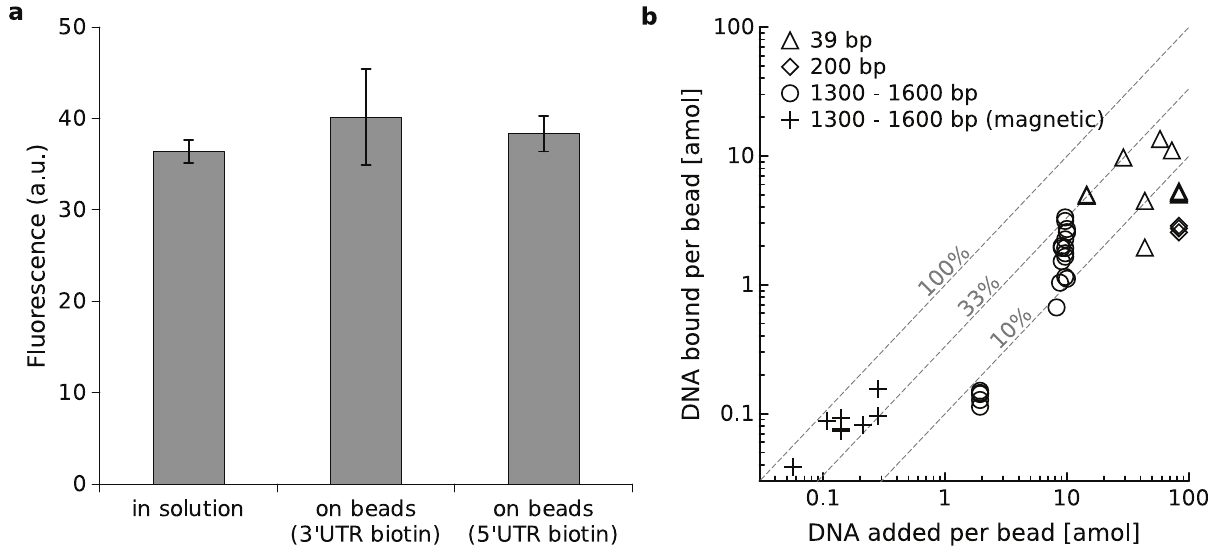
Fig 1. DNA immobilization on beads and expression in ¼ l-scale reactions. (a) Comparison of fluorescent protein expressed in 25 μ l reactions from DNA in solution or equivalent amounts of DNA directly immobilized on beads. Error bars show standard deviation calculated from three replicates. (b) Optimization of direct DNA loading: biotinylated dsDNA fragments of various sizes were incubated with Streptavidin-coated micro beads. Dashed lines: DNA binding efficiency.